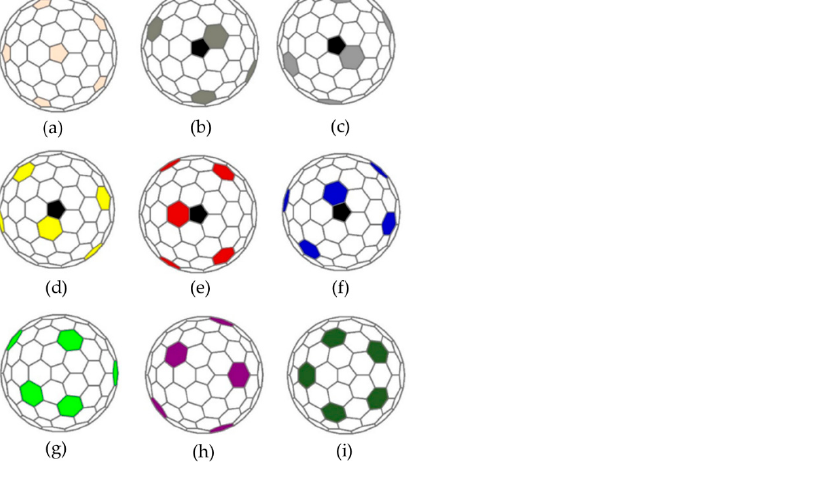
Figure 12. Geometric representation of stator pole phases: ( a – i ) represent phases 1–9, respectively. Phases 2–6 are symmetric about the edges of the central pentagon highlighted in black.